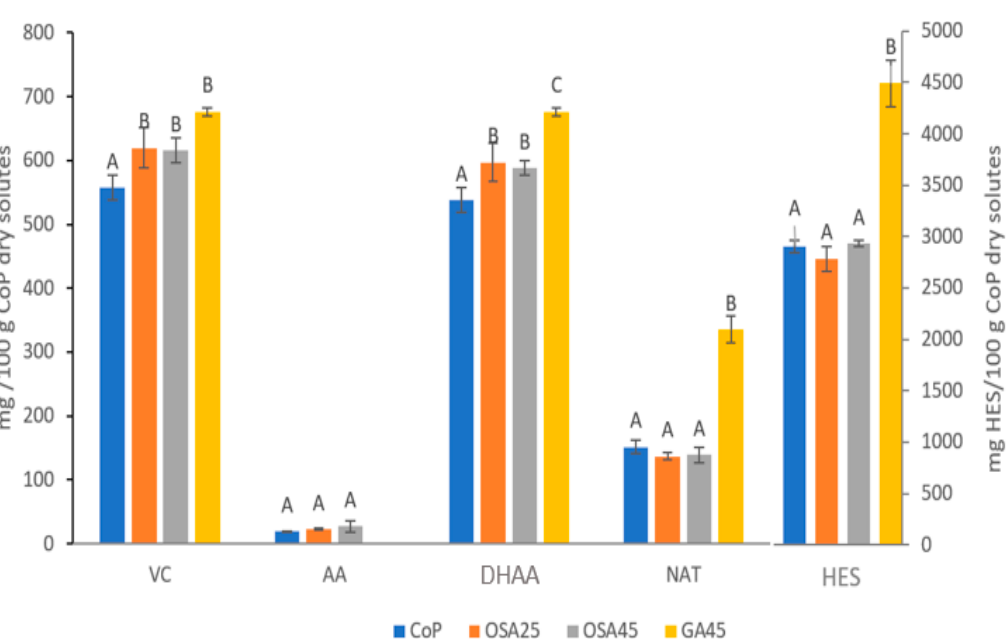
Figure 2. Bioactive compound content of the freeze-dried samples (mg/100 g CoP dry solutes). VC: vitamin C; AA: ascorbic acid; DHAA: dehydroascorbic acid; NAT: narirutin; HES: hesperidin. For each com-pound, different letters (A-C) indicate different homogeneous groups established by Tukey HSD ANOVA (p<0.05).